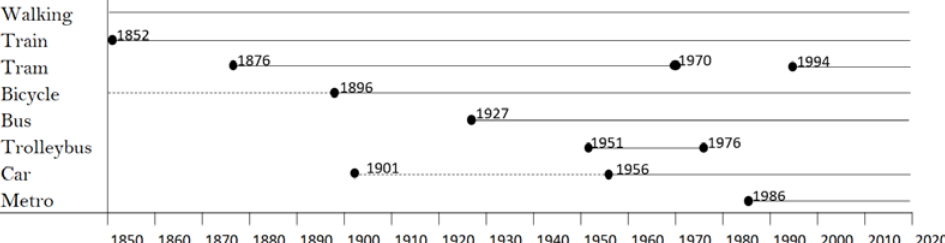
Figure 4. Implementation of means of transport in the city of Valencia (The years in the figure referring to trains, trams, buses, trolleybuses, and the metro correspond to the year in which the first lines were brought into service in the VMA. In the case of bicycles and cars, the points refer to the fact that the means of transport existed, but their use was restricted to a small part of the population. The specific year that is marked as the implementation refers to the year in which these vehicles were considered to be a common means of transport in Valencian society). Data from: [66–68] and the Directorate-General for Traffic (DGT).